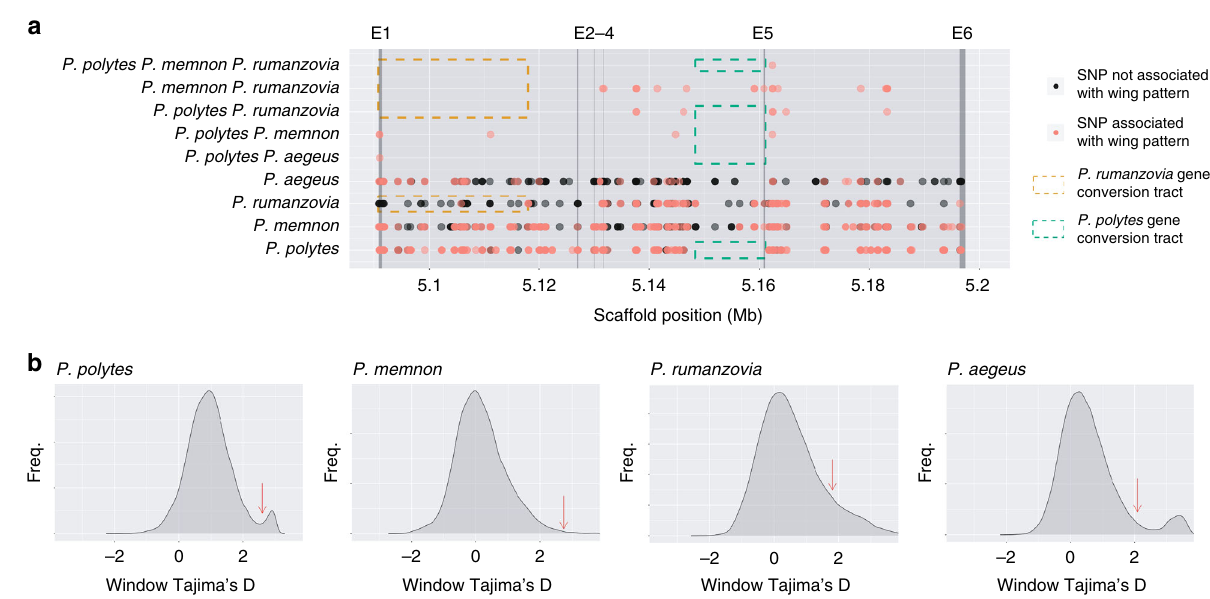
Fig. 6 Trans-species polymorphisms and evidence of balancing selection at dsx . a Unique and shared SNPs across the dsx (gray box) region. Vertical boxes E1 – 6 indicate the dsx exons. Color variation in dots is due to overlapping points. Species combinations not shown had no shared SNPs. b Genome- wide Tajima ’ s D distributions. Red arrows indicate the highest Tajima ’ s D value for dsx